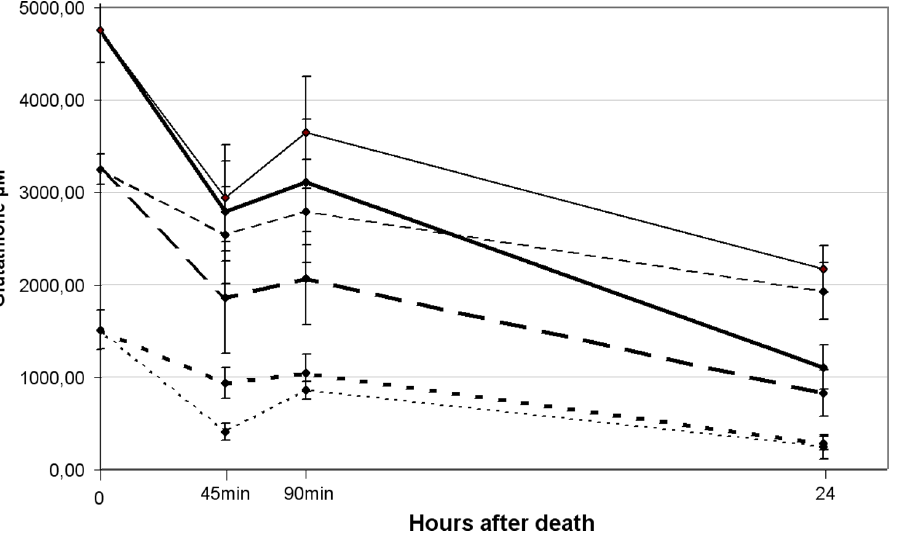
Figure 2. Glutathione in postmortem stored lenses. Storage inside the eye retain glutathione in the lens, although affected by a redox shift of decreased GSH and increased GSSG concentrations. GSSG quickly drop to similar levels as in vitro stored lenses, whereas GSH is lost at a slower rate without any rapid drops. Total glutathione is shown as full lines, GSH as large dotted and GSSG as small dotted lines. Bold lines show the progression in Optisol-GS and thin lines in castor oil.